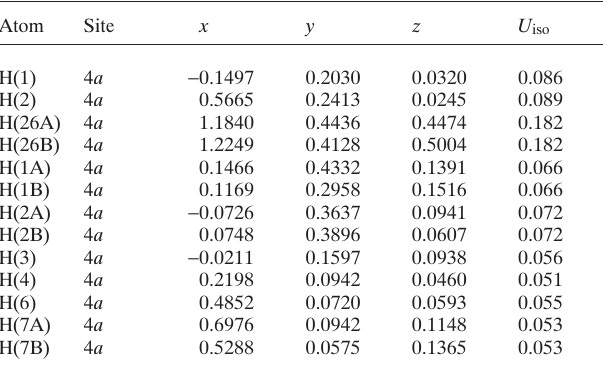
Table 2. Atomic coordinates and displacement parameters (in Å 2 )